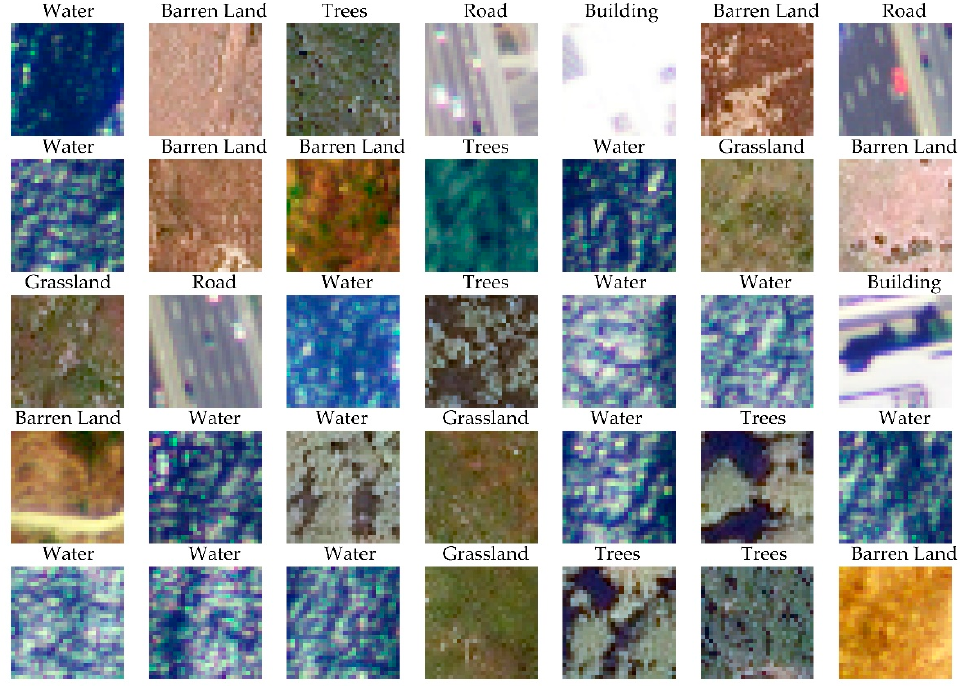
Figure 4. Example DeepSat SAT-6 28-by-28 pixel image chips with associated labels provided by [9]. Table 4. Scene labelling accuracy assessment for DeepSat SAT-6 dataset, with values in the table representing proportions of outcomes based on class prevalence in the benchmark dataset. OA = 0.9967.